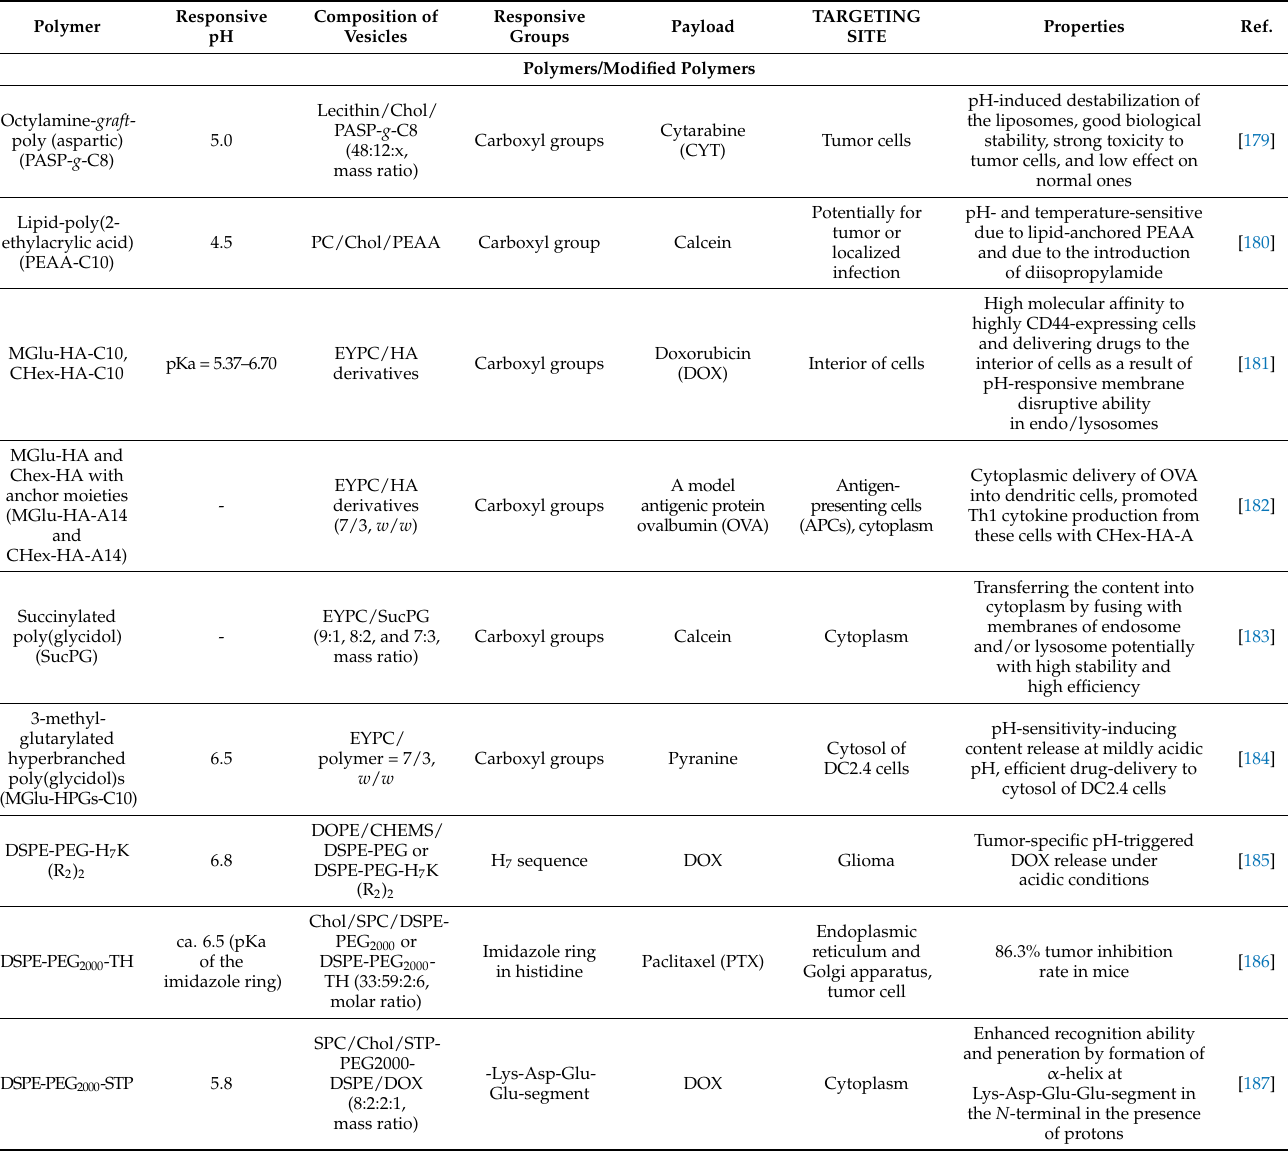
Table 2. pH-responsive polymers for the modification of liposomes for drug